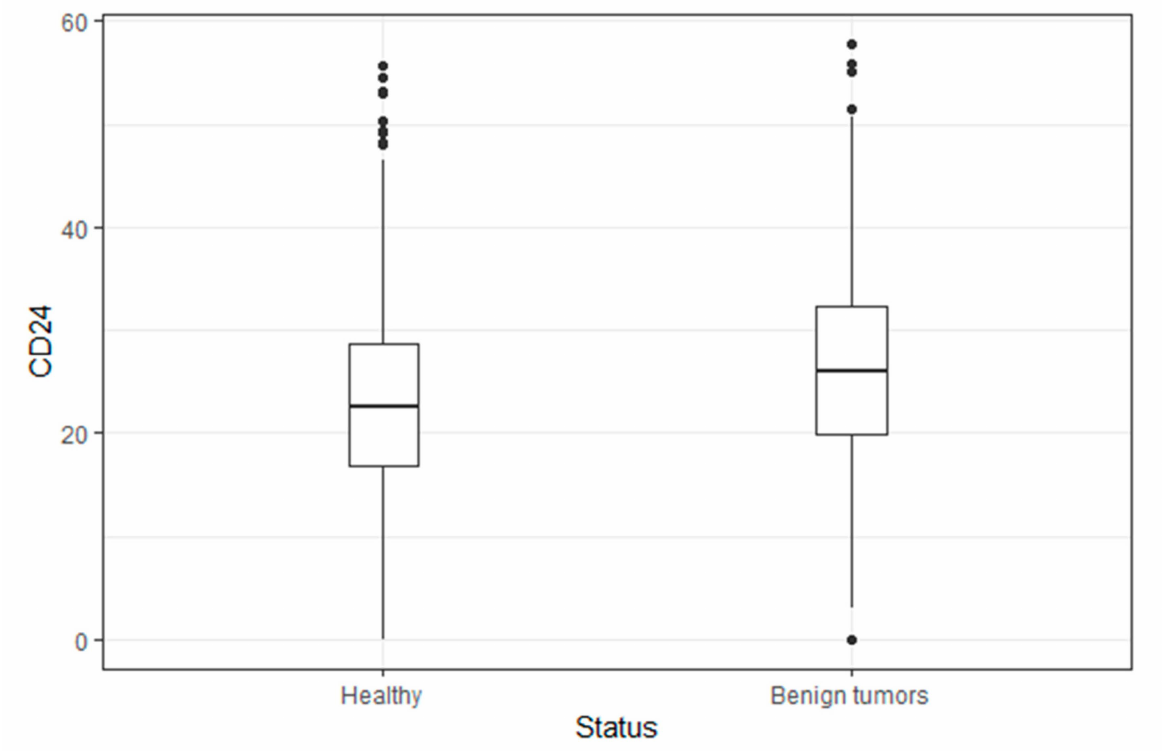
Figure 1. Box plot of the CD24 levels in healthy subjects versus subjects with benign tumors. Flow cytometry analysis showed levels of CD24/CD11b expression in PBLs obtained from study